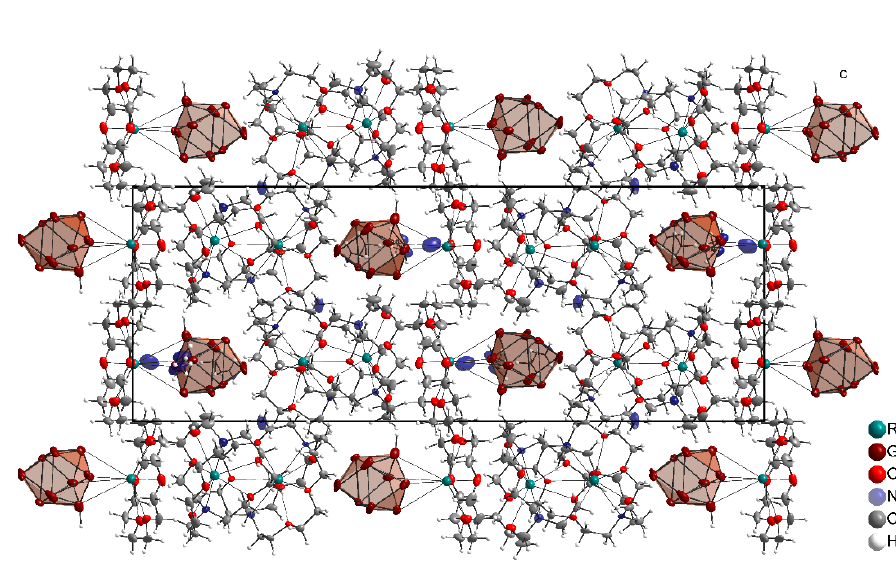
Figure 3. Projection of [Rb([2.2.2]crypt)] 2 [Rb([18]crown − 6)][HGe 9 ] · 4NH 3 along the crystallographic Figure 3 . Projection of [Rb([2.2.2]crypt)] 2 [Rb([18]crown−6)][HGe 9 ]·4NH 3 along the crystallographic a - a -axis. Anisotropic displacement ellipsoids at 50% probability axis. Anisotropic displacement ellipsoids at 50% probability level.